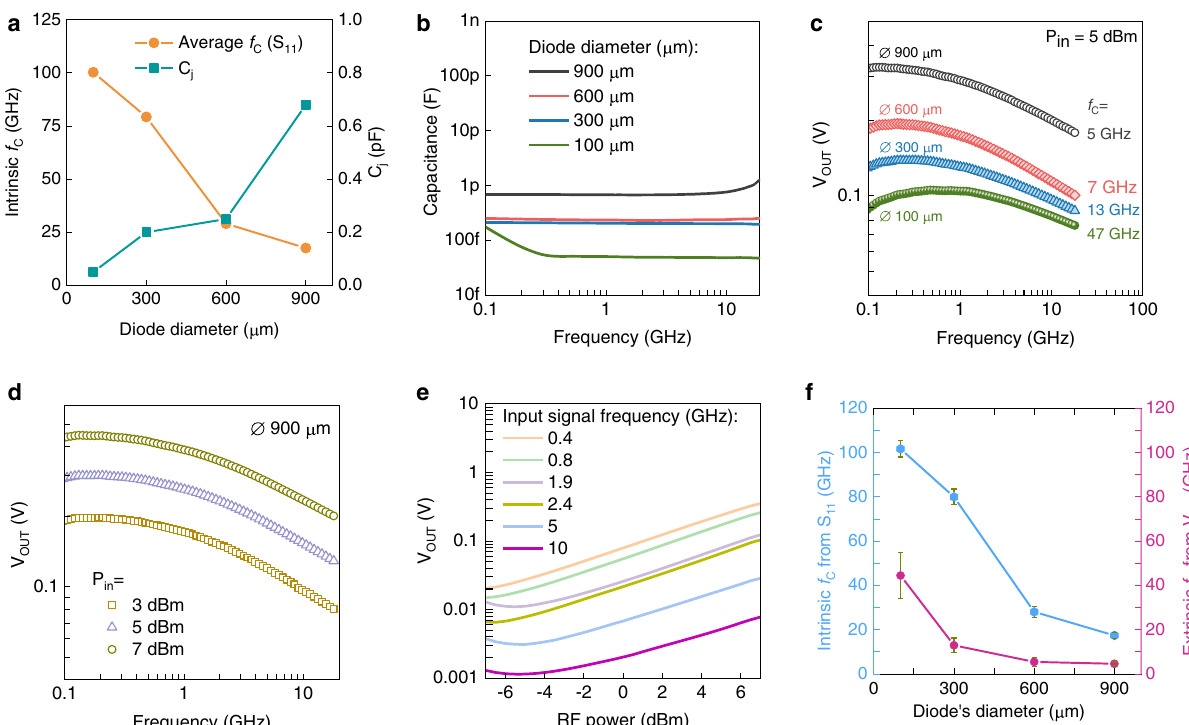
Fig. 4 High-frequency capacitance and recti fi er measurements. a The average intrinsic cut-off frequency and junction capacitance (C j ) of several diodes (for each diameter) measuredfromS 11 one-port measurements.Thecut-offfrequencyisincreasingas thediode ’ sdiameterisreduced.Ontheother hand,C j (measured at10GHz)isreducingfordecreasingdiameters. b ThejunctioncapacitanceofAl/IGZO/Ti-PtdiodesextractedfromS 11 measurementsintherangefrom0.1GHzto 18GHz. In all cases, C j displays ultra-small values (<1pF). c The recti fi ed voltage output vs. input frequency at 5dBm power input. The extrinsic cut-off frequencies wereextractedat thehalfpowerpoint.Thepower-dependent( d ) and frequency-dependent ( e )voltageoutput ofa diodewitha diameterof900 µ m. f Dependence of the intrinsic cut-off frequency, (f C,int , from S 11 ), and extrinsic cut-off frequency, ( f C,ext , from voltage output measurements), measured for 10 diodes per diameter indicating the clear increase in f C with reducing diode width. The error bar indicates the standard deviation of the cut-off frequency of the diodes. fi eld emission electron source at the operating voltage of 5kV. For cross sectional TEM images, fi rstly, a thin lamella was prepared with the focused ion beam (FIB) in a scanning electron microscope (Helios 400 s, FEI) equipped with a nano manipulator (Omniprobe, AutoProbe300). The sample ’ s surface was protected by the sequential layers of carbon and platinum deposited under electron and ion beams. The bulk of the sample was milled with a Ga ion beam to reach the depth of ca. 8 – 10 μ m. An under-cut was made with the FIB, and the lamella was extracted from the bulk with the help of a nanomanipulator. The lamella was attached to a copper TEM grid and thinned down with FIB at 30 kV and sequentially reducing the current in the range of 2.8nA to 93 pA. The lamella was polished with the FIB at low voltages (5 and 2kV) to remove any possible contamination. Then, the cross-sectional images were acquired with the TEM (Titan 80 – 300, FEI, equipped with an electron monochromator and Gatan Imaging Filter, GIF Quantum 966) at 300 kV operating voltage. The electron energy loss spectroscopy (EELS) images were acquired in the scanning TEM (STEM) mode called spectrum imaging (SI).